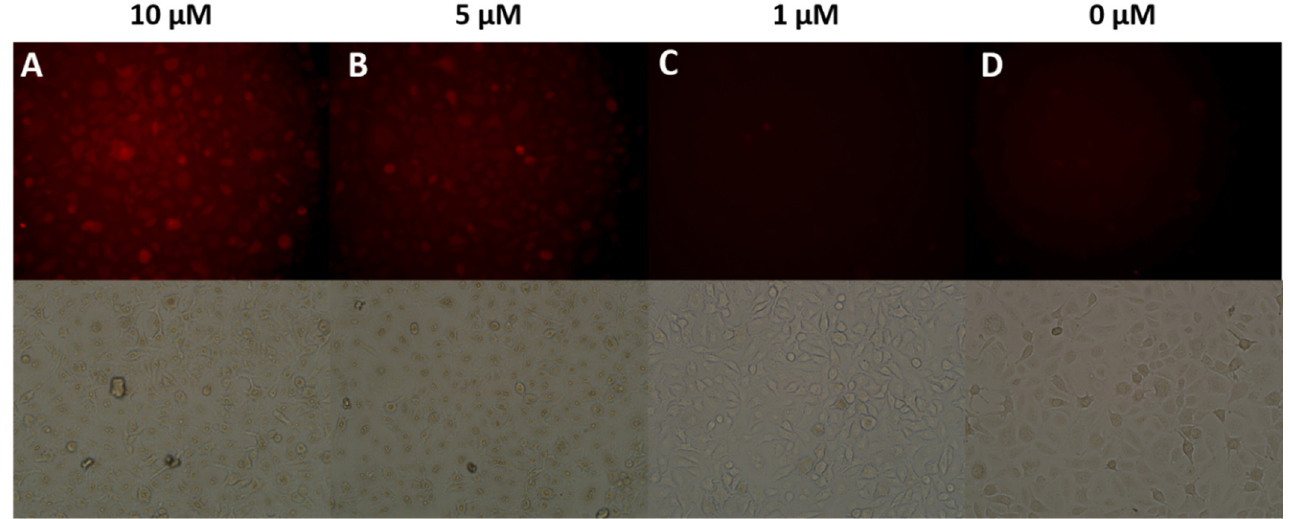
Figure 8. Fluorescence microscopy images of HeLa cells incubated with various concentrations of mPEG-b-P(PA-alt-AGERh) nanosensor, including: ( A )10, ( B ) 5, ( C ) 1 and ( D ) 0 μ M for 6 h at 37 °C. First row: fluorescence images at the red channel (560–700 nm) and second row: bright field images. λ ex = 560 nm.